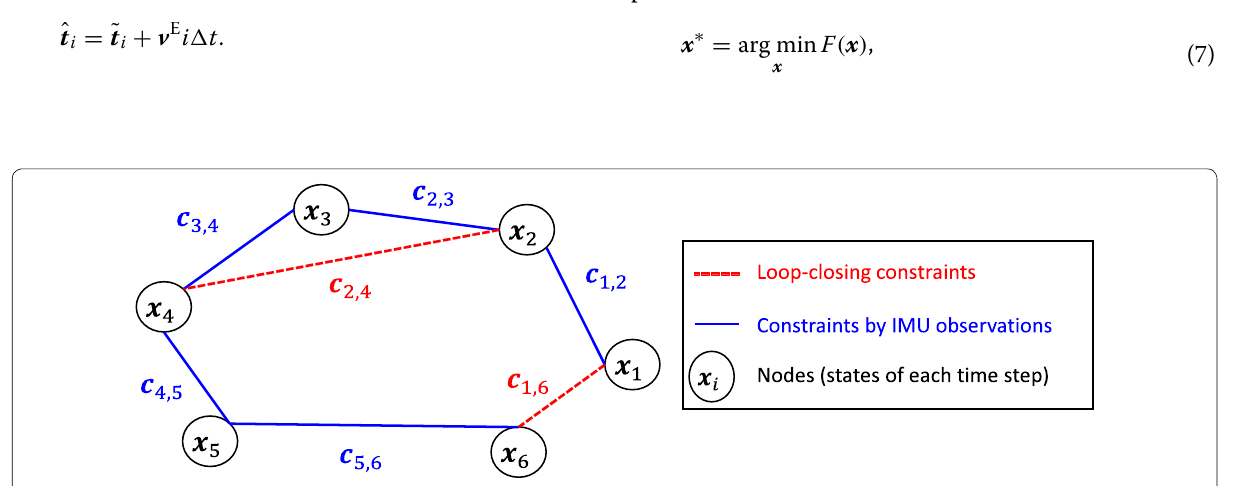
Fig. 1 Sample graphical